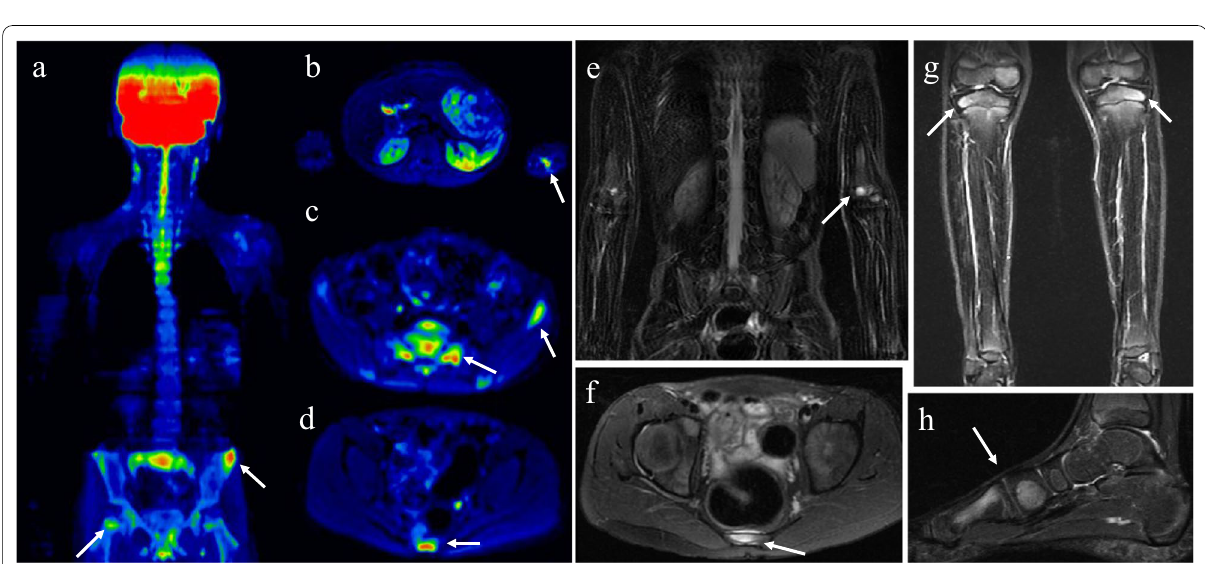
Fig. 9 MRI protocol. Coronal T1 ( a ), coronal STIR ( b ), reconstructed coronal DWI inverted grayscale ( c ), sagittal STIR ( d ) of the whole spine and sagittal STIR of the feet ( e )